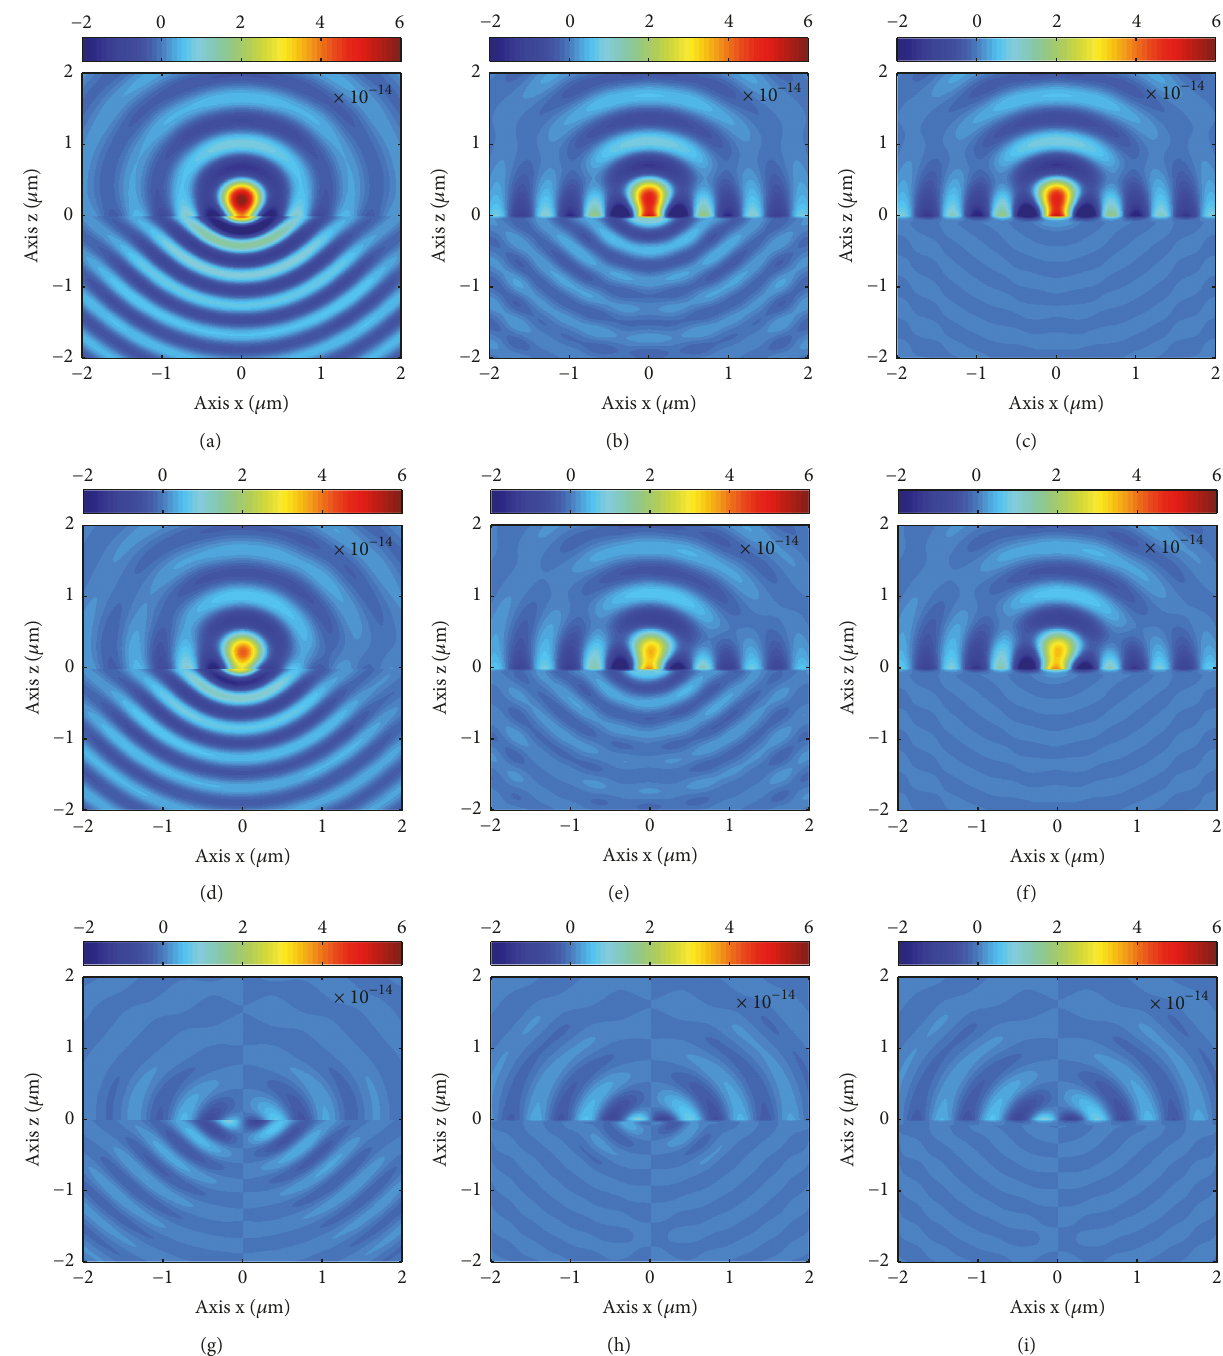
Figure 9: Magnetic Potential Field 𝐴 𝑧 for 𝜃 󸀠 = 0 ∘ : (a) 𝛿 𝑔 = 10𝑛𝑚 , (b) 𝛿 𝑔 = 50𝑛𝑚 , and (c) 𝛿 𝑔 = 100𝑛𝑚 ; 𝜃 󸀠 = 45 ∘ : (d) 𝛿 𝑔 = 10𝑛𝑚 , (e) = 50𝑛𝑚 , and (f) 𝛿 = 100𝑛𝑚 ; 𝜃 󸀠 = 90 ∘ : (g) 𝛿 𝛿 𝑔 𝑔 ℎ = 200𝑛𝑚 , Δ = 10𝜇𝑚 , 𝜆 = 632.8𝑛𝑚 , and 𝜙 󸀠 = 0 ∘ . 𝑐